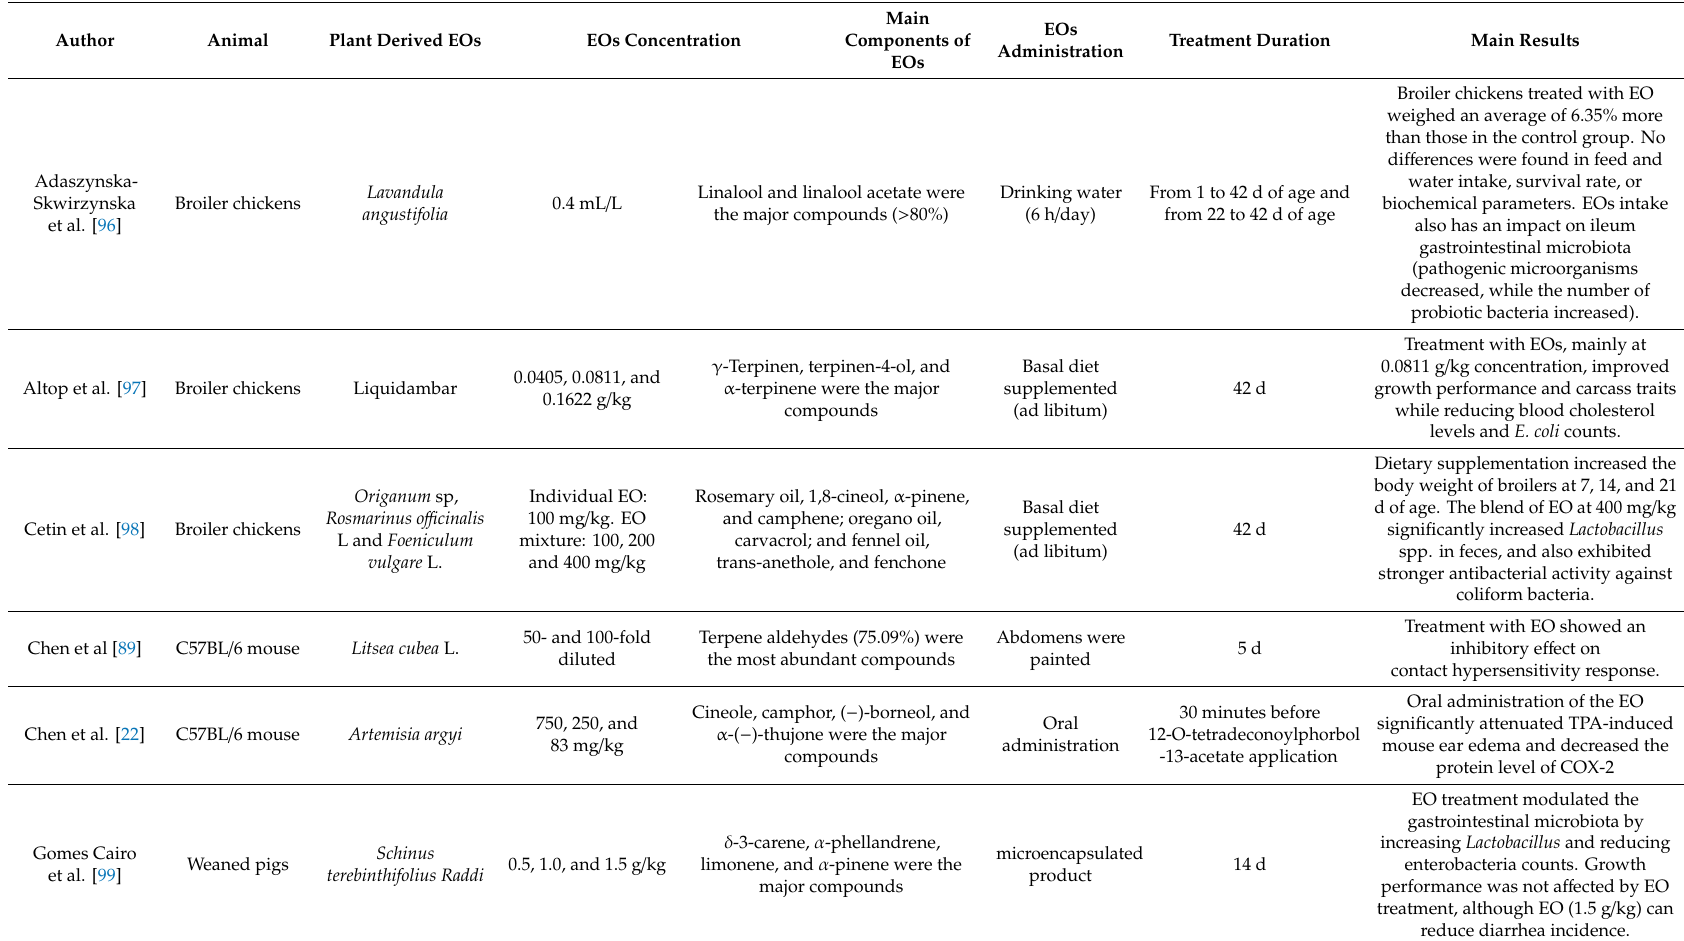
Table 5. Main characteristics of studies related with immunomodulatory properties of essential oils in